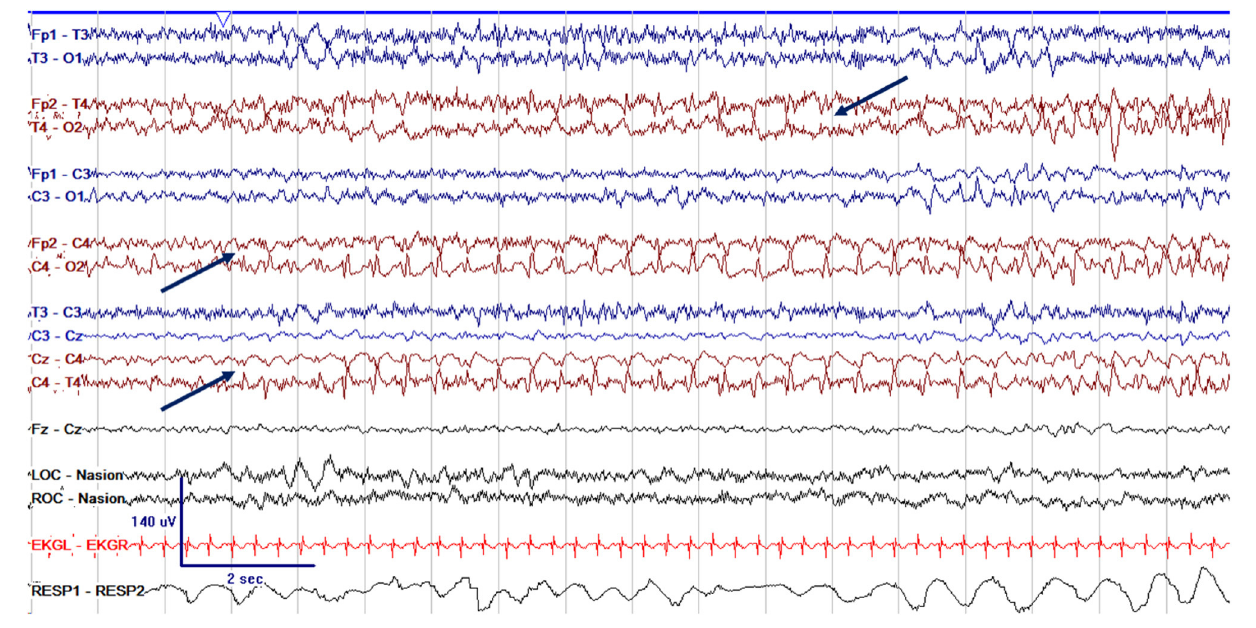
FIGURE 7 | cEEG of a focal electrographic only seizure (arrows) arising from the right central region (C4), with spread to the right temporal region (T4) in a 3 week old former 38 + 4 week GA (41 + 4 week PMA)